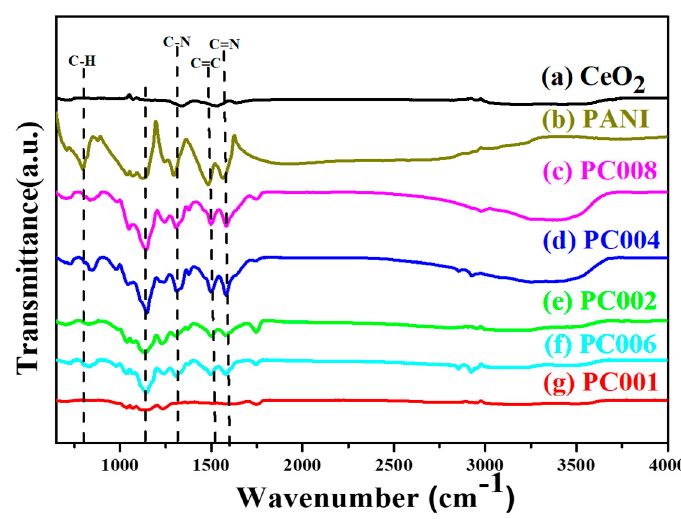
Figure 4. FTIR spectrum of the CeO 2 / PANI powders as a function of the amount of PANI coating.